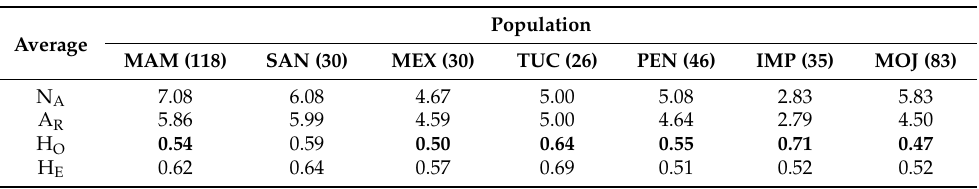
Table 1. Genetic diversity estimated by 12 microsatellite loci for three wild and four farmed popula- tions of the A. gigas .